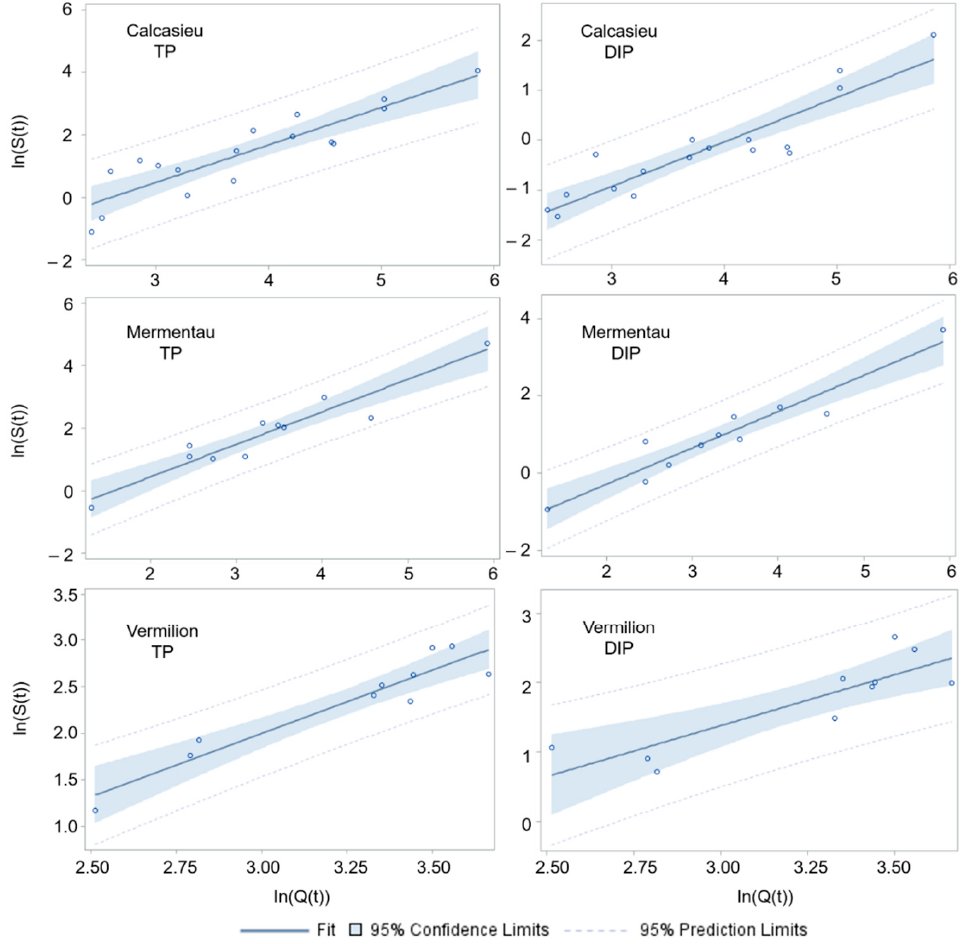
Figure A3. Statistical performance of the rating curves (Table 1) for estimating TP and DIP daily fluxes of the Calcasieu (Site 1), Mermentau, and Vermilion Rivers from April 2014 to February 2016 using data collected from this study.